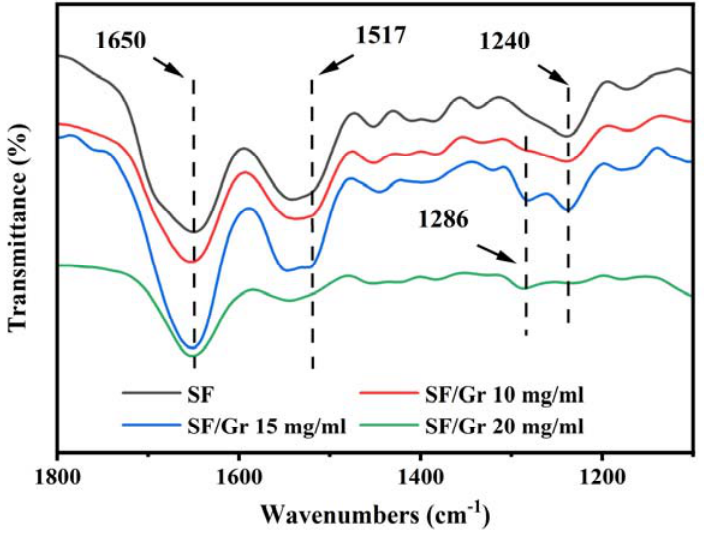
Figure 4. FTIR spectra of SF, SF/Gr 10 mg/mL, SF/Gr 15 mg/mL, and SF/Gr 20 mg/mL nanofiber membranes.